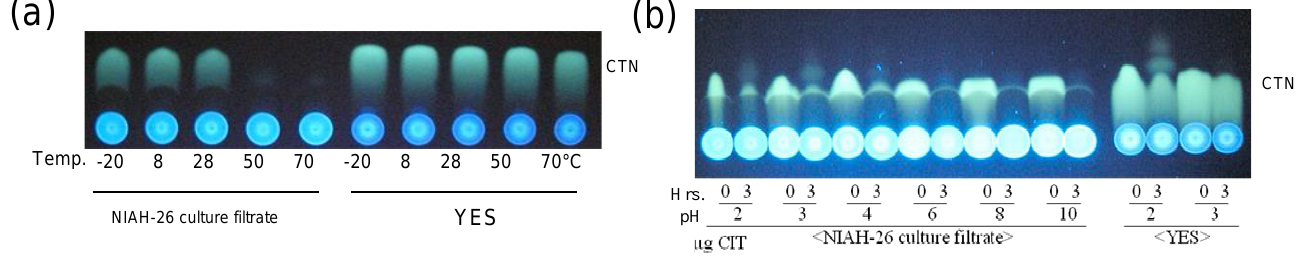
Figure 5. The disappearance of CTN fluorescence by filter-sterilized culture medium: ( a ) The culture medium of NIAH-26 was sterilized by filter filtration, the resulting culture filtrate was incubated with CTN at various temperatures for 3 h, and the resulting medium was analyzed by TLC; ( b ) the sterilized medium filtrate of NIAH-26 or YES medium was adjusted to various pH values, and then added with 105 μg ml −1 CTN, and then incubated at 50 °C for 3 h, and the resulting media were analyzed by TLC using developing solution 2.